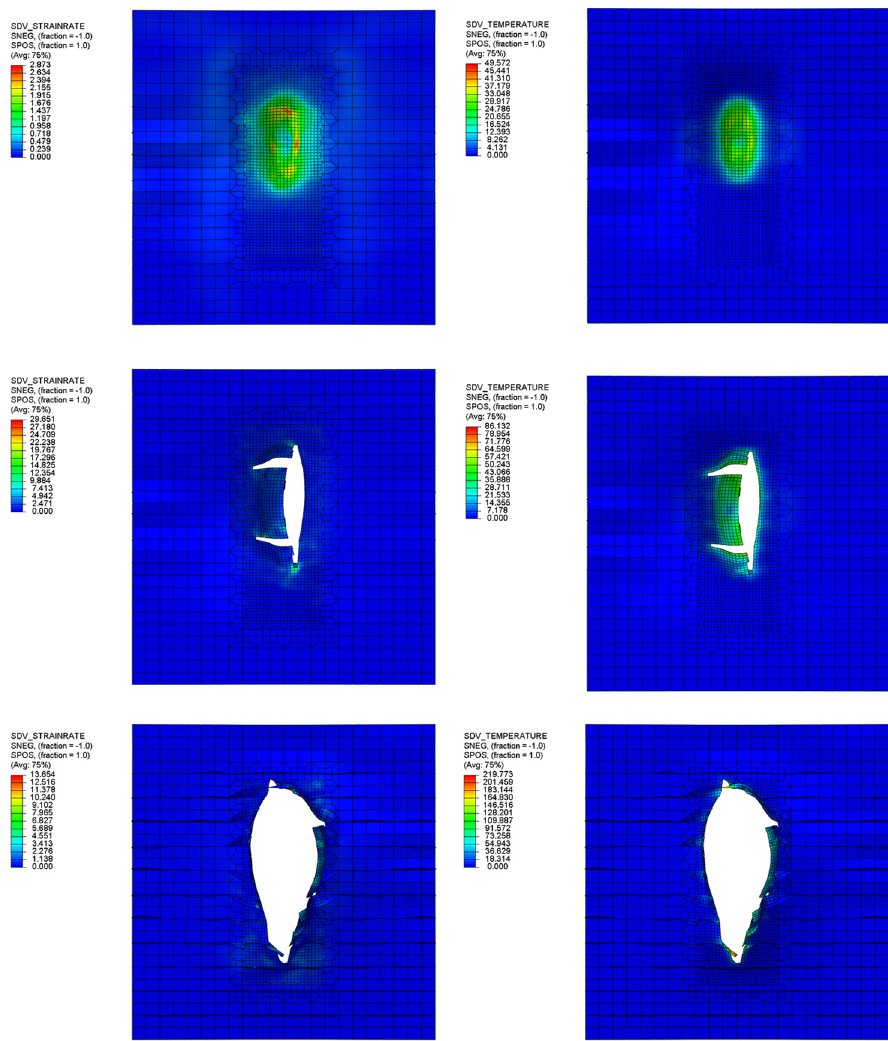
Figure 11. Equivalent plastic strain rate and temperature increase in the outer shell panel at various stages of rupturing. Fracture preceded by necking is the dominant failure mechanism in a typical ship- side collision. The adopted rate-dependent combined necking and fracture model pro- vided insights into the local strain rate variations and temperature increase in deforming and failing structural members. On the other hand, necking-based fracture modeling ig- nored the post-necking response and did not attempt to model the localization associated with high strain rates and temperature increases. In a low-velocity impact, the strain rate